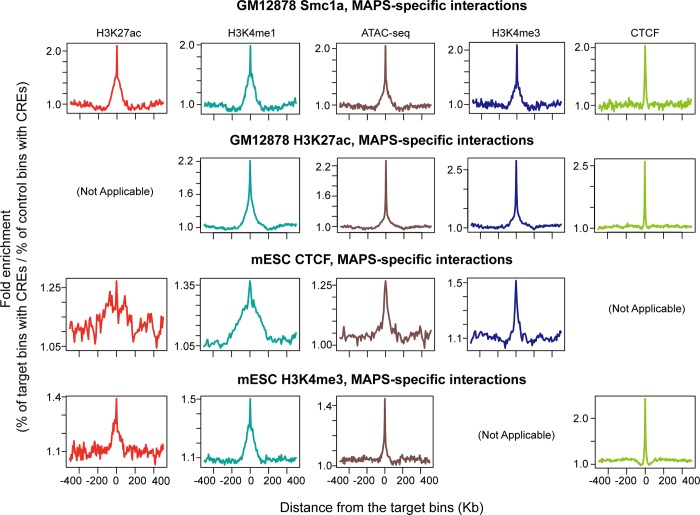
Enrichment of CREs around the target bins of XOR set of MAPS-specific interactions.Enrichment of H3K27ac (ChIP-seq peaks), H3K4me1 (ChIP-seq peaks), ATAC-seq peaks, H3K4me3 (ChIP-seq peaks) and CTCF (ChIP-seq peaks) in a window of 500Kb around the target bins for all four datasets. Due to the definition of XOR set of interactions, H3K27ac, H3K4me3 and CTCF enrichment level is not analyzed for GM12878 H3K27ac HiChIP, mESC H3K4me3 and mESC CTCF PLAC-seq data, respectively.